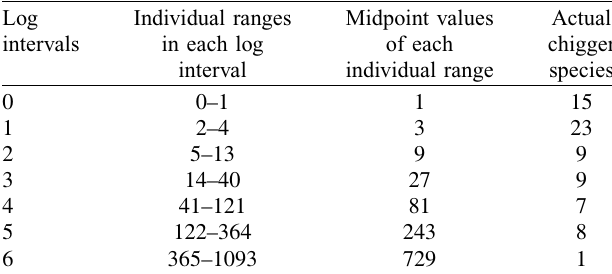
Table 7. Species abundance distribution of the chigger community on Anourosorex squamipes in Southwest China (2001 – 2019).